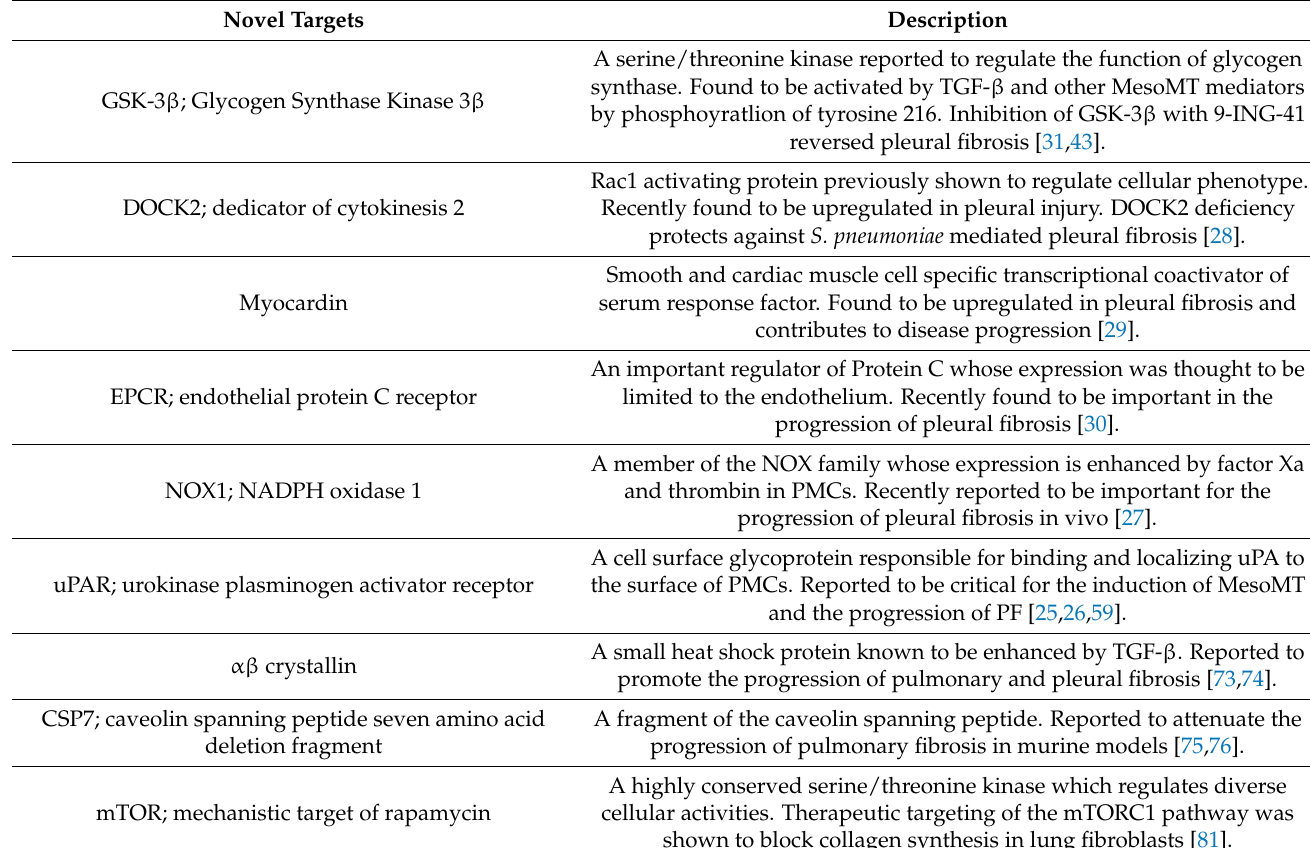
Table 2. Novel targets for interventional